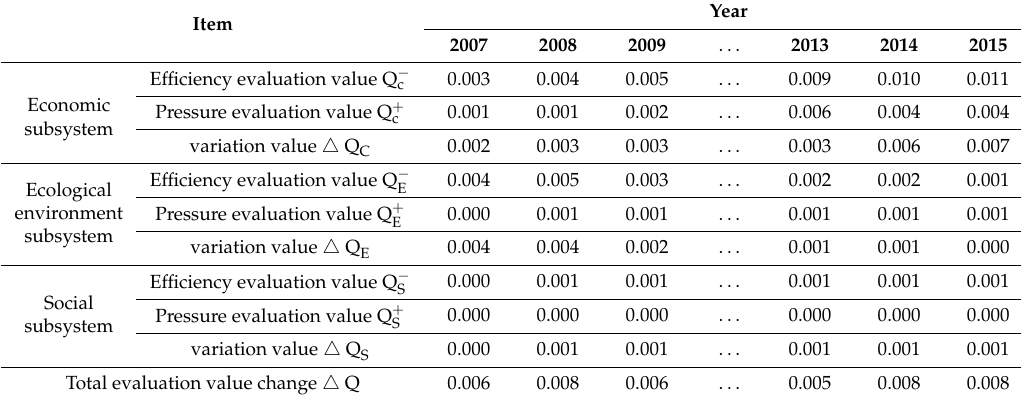
Table 5. Quantitative evaluation of the